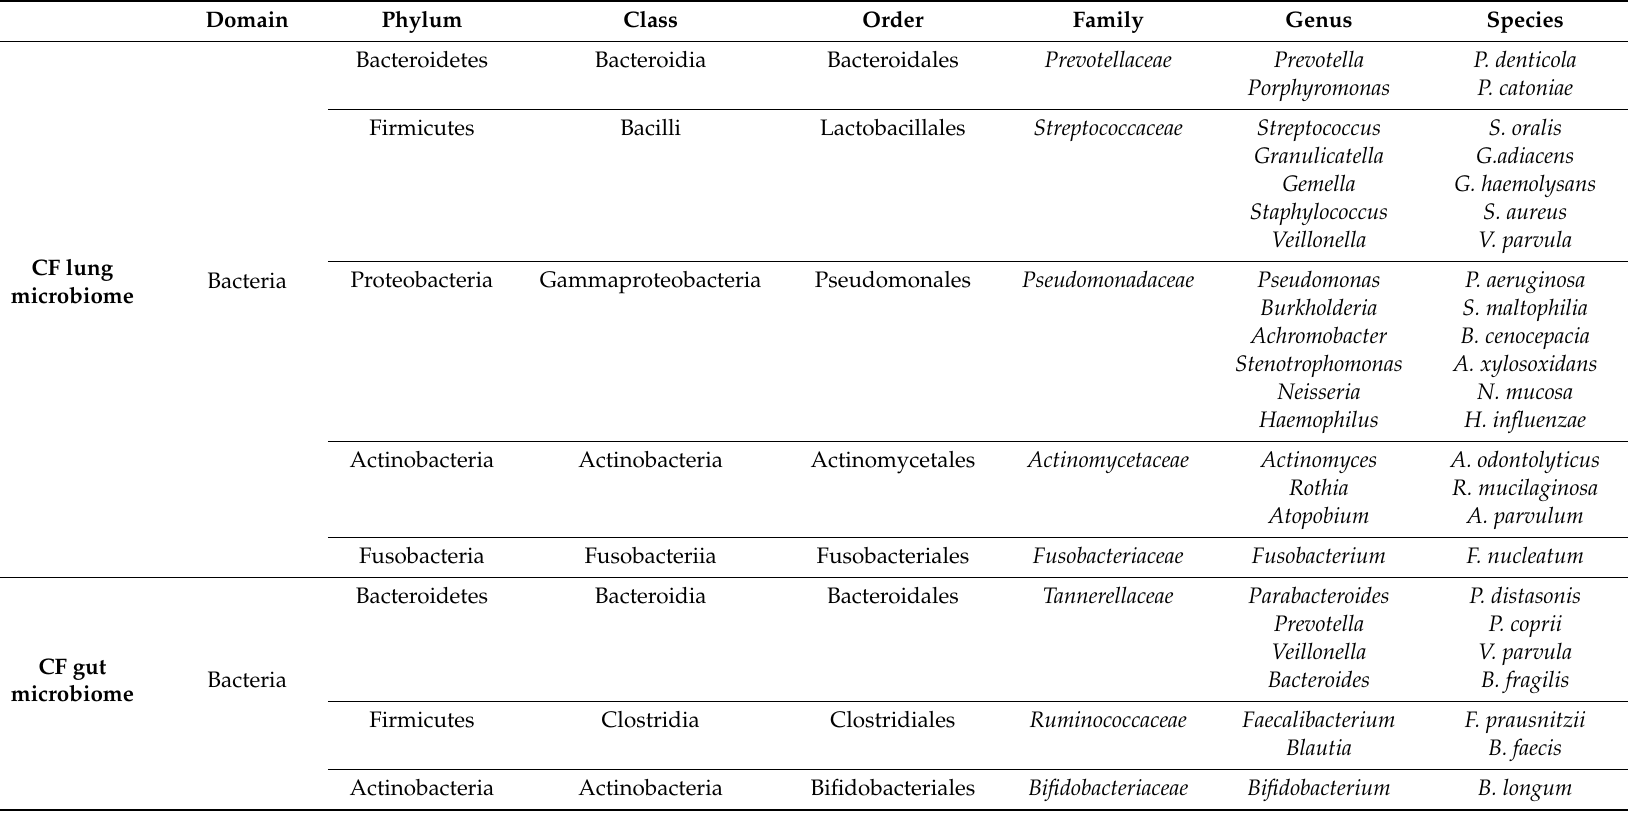
Table 1. Principal taxa in gut and lung cystic fibrosis (CF) microbiomes, presented according to bacterial taxonomy